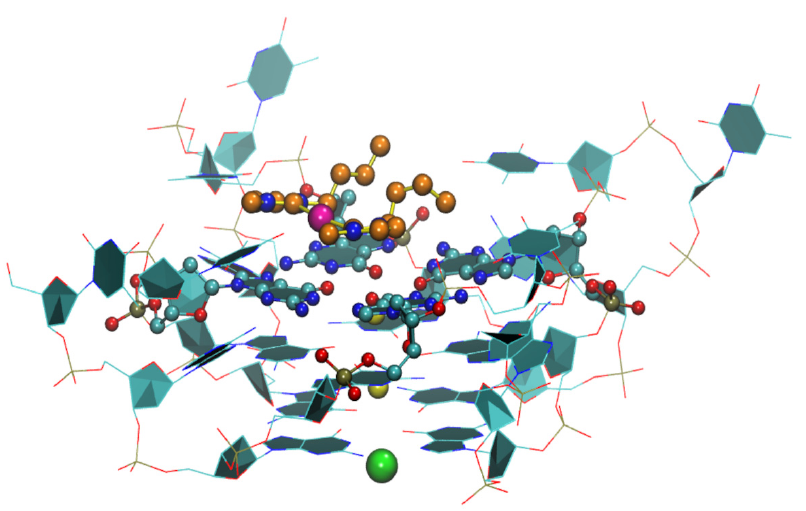
Figure 9. The crystal structure of a G-quadruplex unit bound to one gold complex in the [Au(NHC) 2 ] + /Tel24 adduct [66]. The following color code has been used to identify each sin- gle atom: magenta (Au + ),yellow (K + ), green (Sr 2+ ) and orange (C of carbene ligands). (from PDB, code